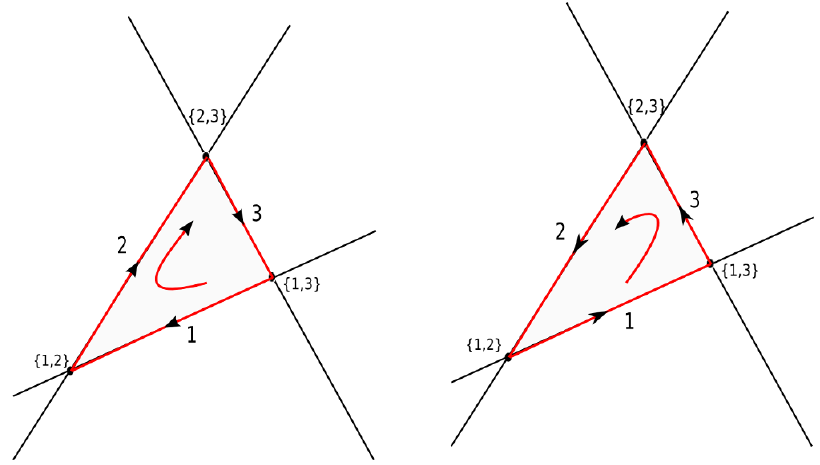
Figure 2 . The two di(cid:11)erent orientations of a